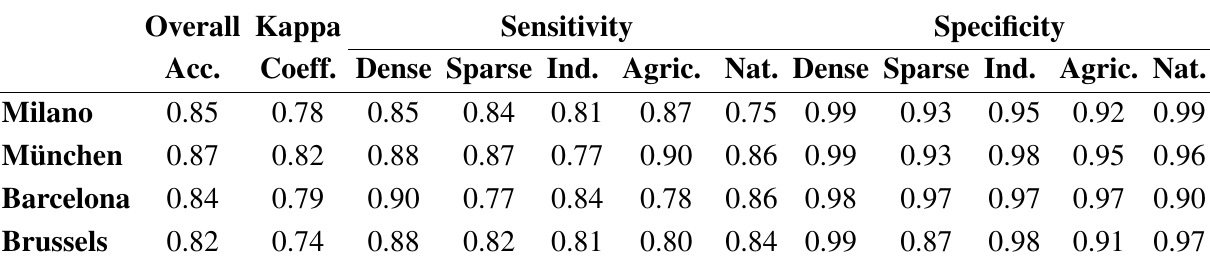
Table 1. Overall accuracy, kappa coefficient, sensitivity and specificity of the five classes (dense residential, sparse residential, industrial, agricultural,